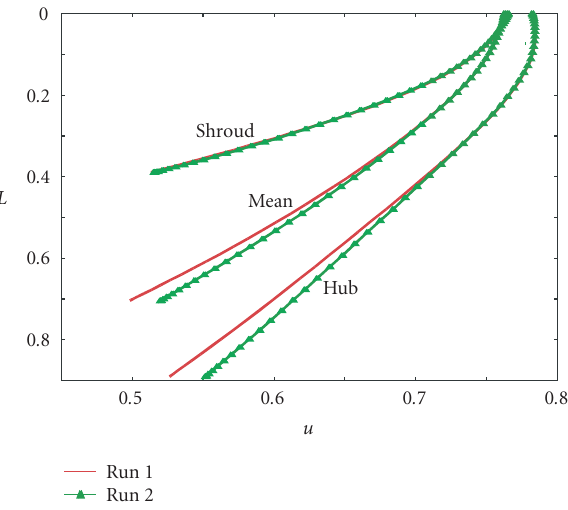
Figure 11: Conformal mapping representation of the runner blade for the first and second optimization runs.